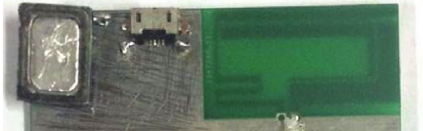
Figure 9: Photograph of loading USB and microphone on this antenna.